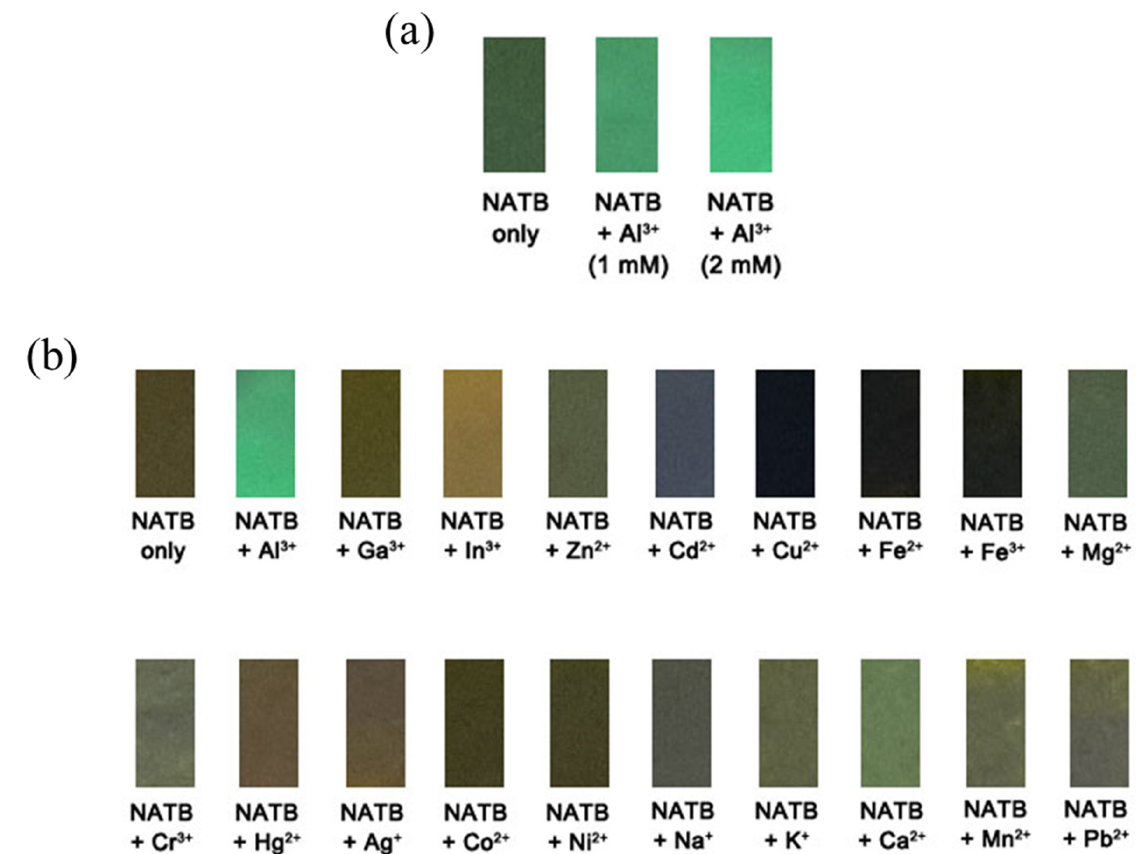
Figure 5. Detection of Al 3+ by NATB -coated test kits (10 mM). ( a ) NATB -coated test kits immersed in the solution of different Al 3+ concentrations; ( b ) NATB -coated test kits immersed in 2 mM of various cation